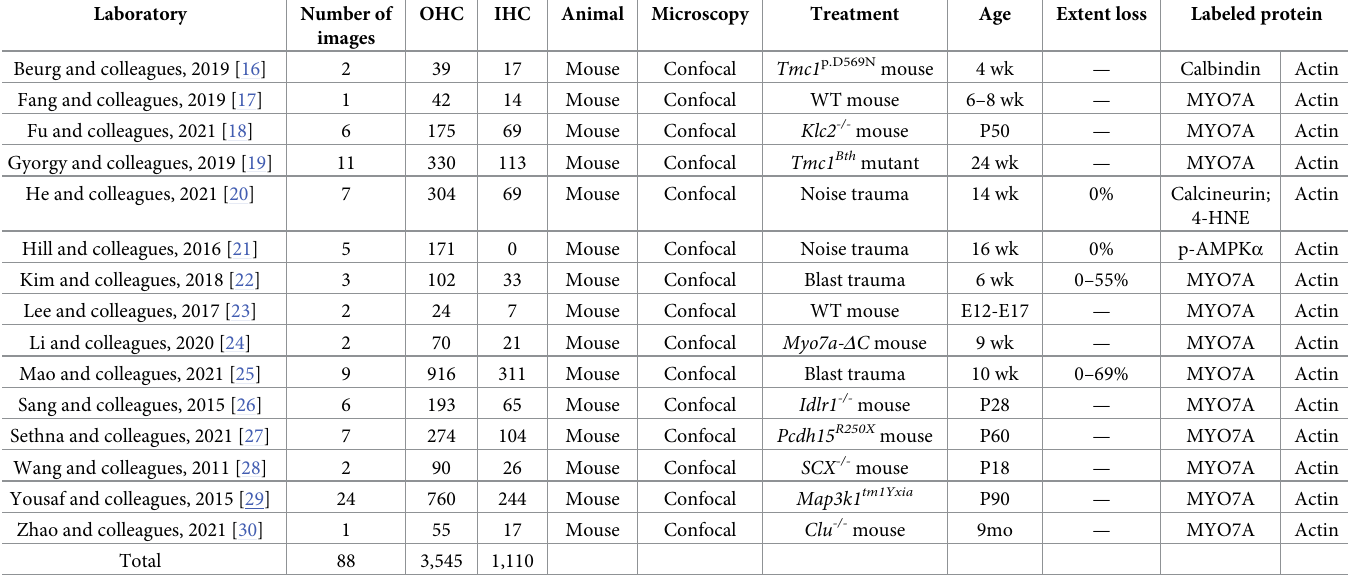
Table 2. Summary of micrographs sampled from existing publications to test HCAT performance.